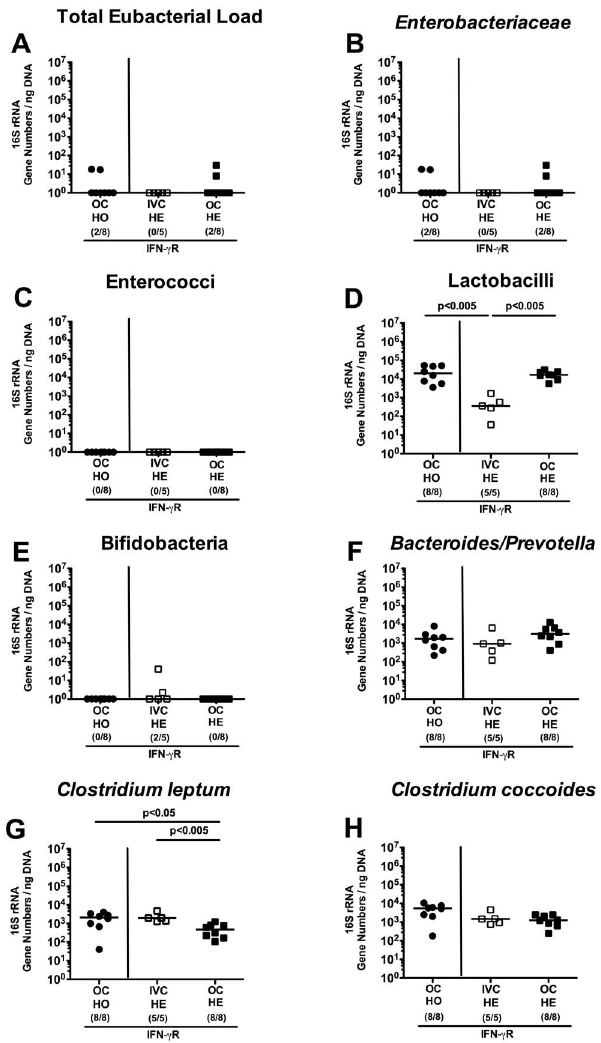
Figure 5. Commensal intestinal microbiota composition of IFN- c Receptor deficient mice kept in IVC or open cages. After eight weeks housing of gene-deficient mice heterozygous (HE) or homozy- gous (HO) for the IFN- c Receptor (IFN- c R) in IVC (white symbols) or open cages (OC; black symbols), 16S rRNA of main intestinal bacterial groups was quantified in individual fecal samples. ( A ) Total eubacterial loads and quantitative abundance of ( B ) Enterobacteriaceae , ( C ) enterococci, ( D ) lactobacilli, ( E ) bifidobacteria, ( F ) Bacteroides/Prevotella spp., ( G ) Clostridium leptum group, and ( H ) Clostridium coccoides group are expressed in gene numbers per ng DNA. Medians (black bars), levels of significance ( P -values) determined by the Mann-Whitney-U test and numbers of analyzed animals (in parentheses) are indicated. doi:10.1371/journal.pone.0113406.g005 commensal bacterial groups in four immune-compromized mouse lines kept in different housing conditions.